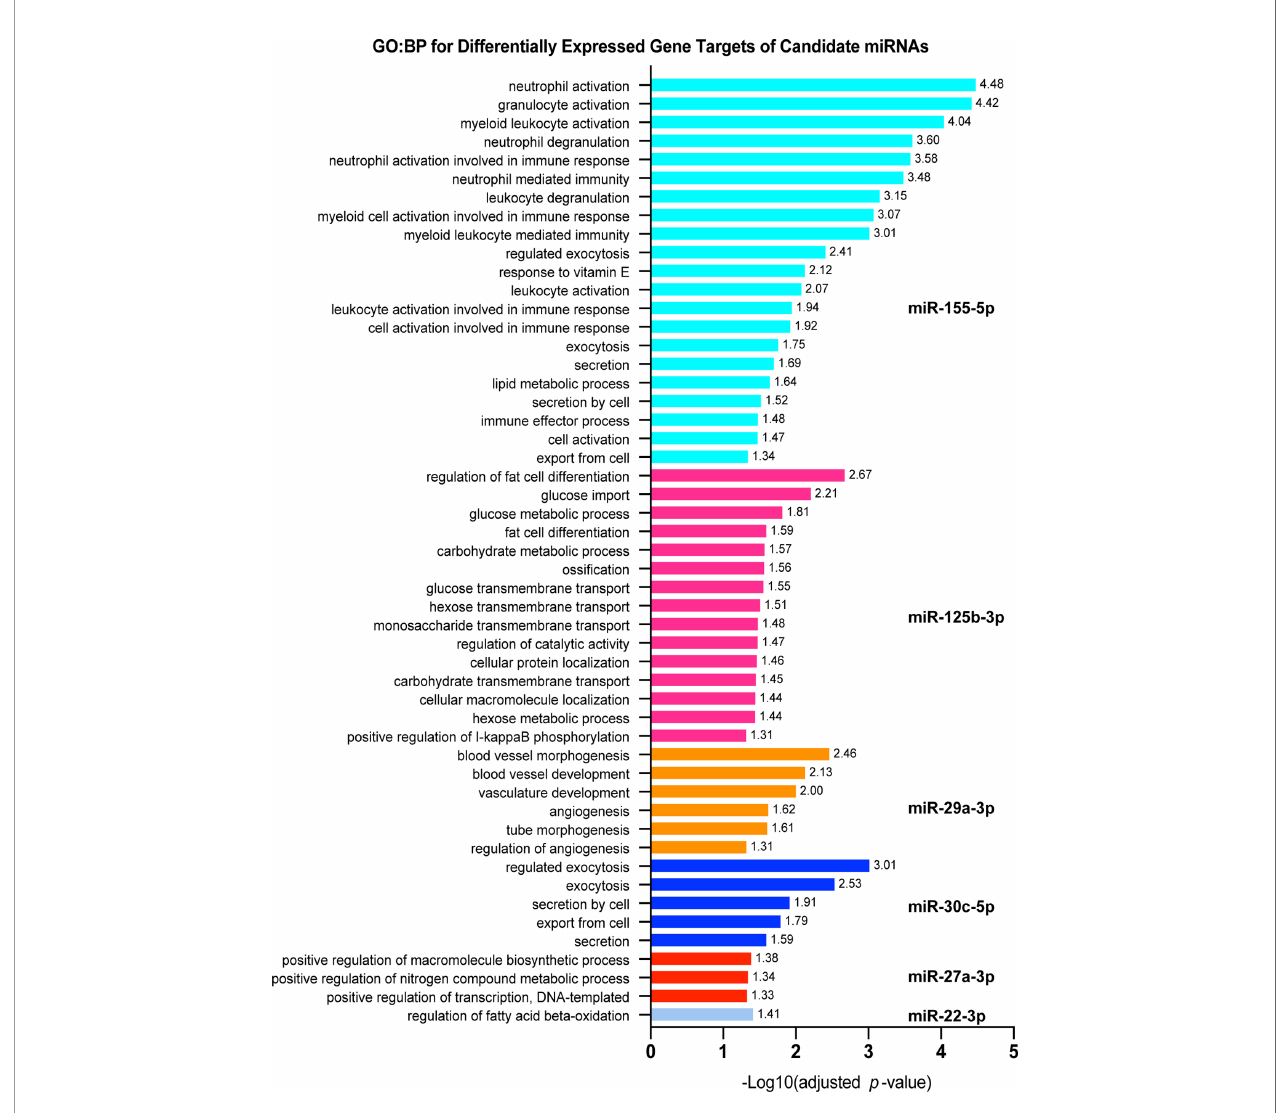
FIGURE 4 | Pathway analysis for signi fi cantly dysregulated targets of candidate miRNAs. Each shows gpro fi ler2 (g:OSt) results for a miRNA candidate. g:OSt was used to analyze the association of each miRNAs target genes with Gene Ontology biological processes functional groups (GO : BP). All signi fi cant GO : BP associations are reported. miRNAs which do not have GO : BP results listed did not have signi fi cant associations with any GO : BP functional group. g:OSt MIRNA was used to determine which miRNA is most signi fi cantly associated with each list of dysregulated targets. The top miRNA hit for each is